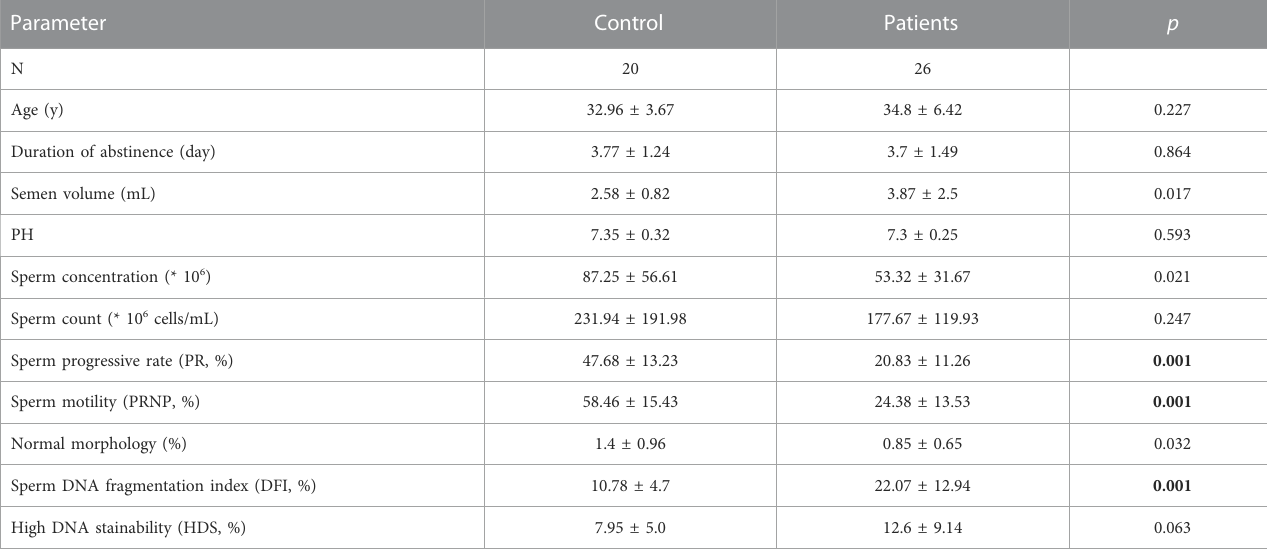
TABLE 2 The semen parameters of 20 control and 26 patients.